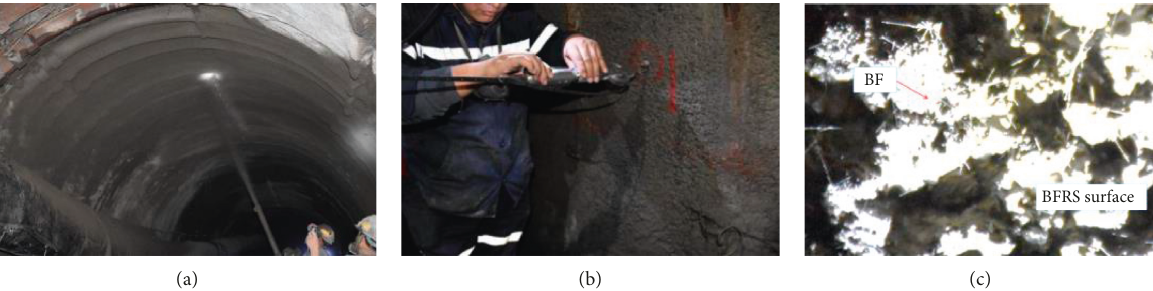
Figure 14: Shotcrete support of underground roadway: (a) concrete in-situ shot, (b) wall convergence monitoring, and (c) BF distribution on shotcrete surface.